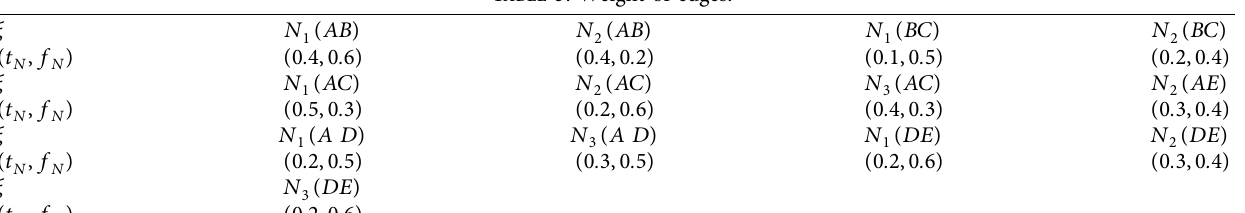
Table 3: Weight of edges.